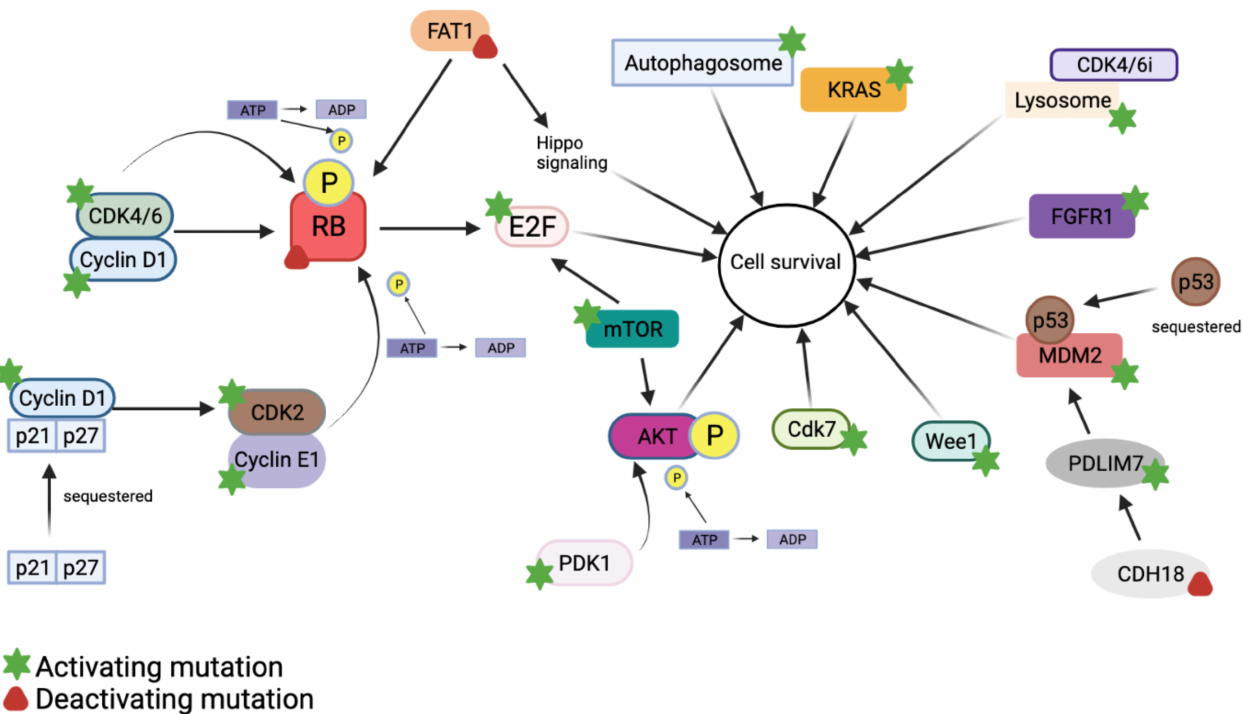
Figure 1. Activating and deactivating mutations identified to date that allow cells to survive in the presence of CDK4/6 inhibitors. Activation of cyclin D1, CDK4/6, CDK2, cyclin E1, E2F, PDK1, mTOR, CDK7, Wee1, PDLIM7, MDM2, FGFR1, KRAS, the lysosome, and the autophagosome can help cells push through the cell cycle when CDK4/6 are pharmacologically inhibited. Deactivation of RB, FAT1, and CDH18 can lead to similar effects on cell cycle progression and overall cell survival. Mutations in each of these proteins and cellular components help the cell to survive via a variety of mechanisms, which are detailed in Section